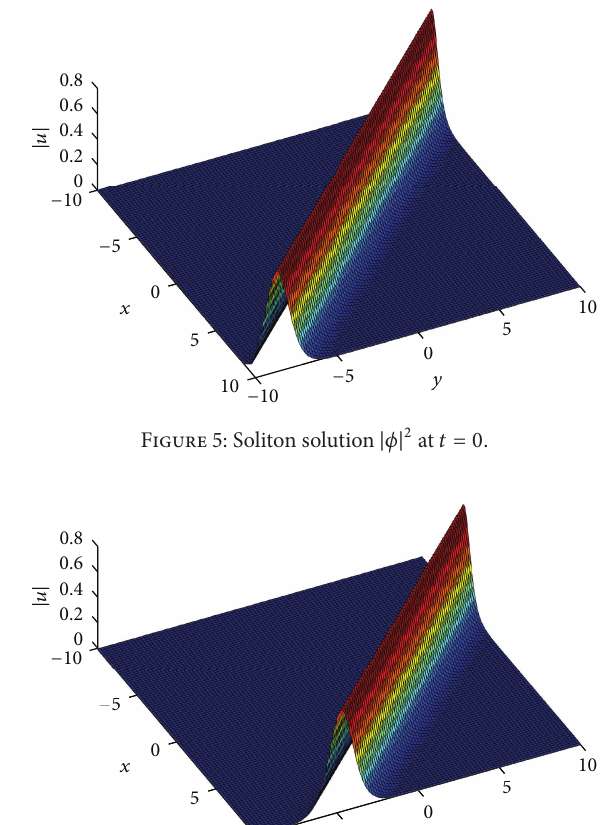
Figure 8: Interaction of two solitons |𝜓| 2 and |𝜙| 2 at 𝑡 = 0.5 . Table 4: The conserved quantities during the interaction scenario.